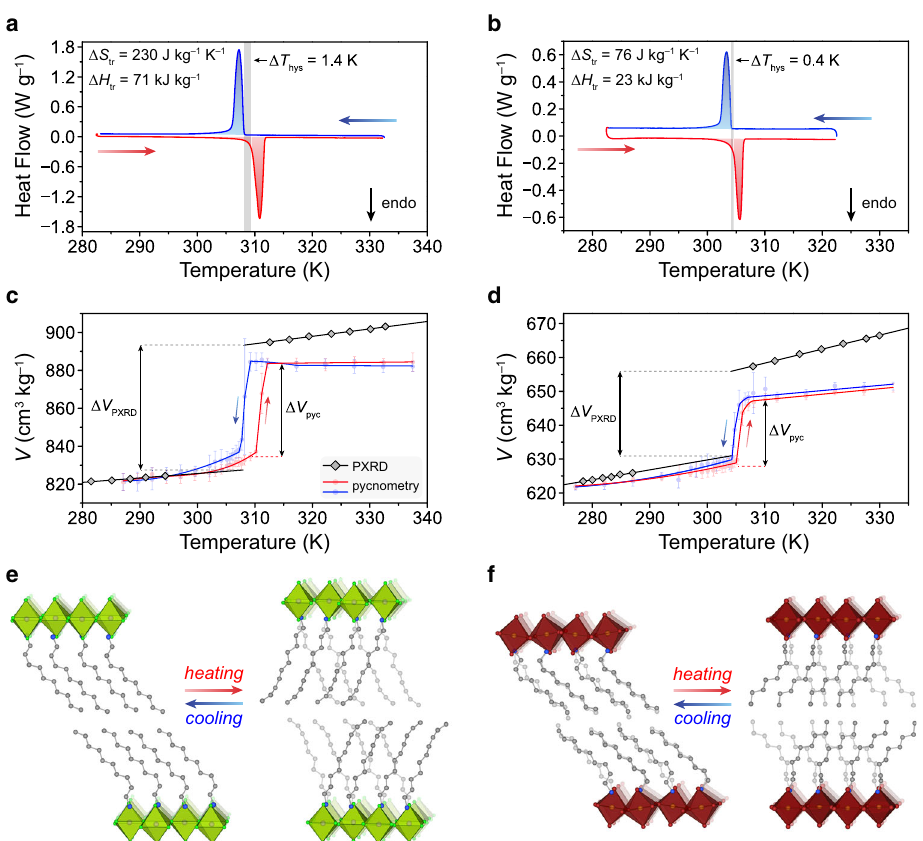
Fig. 2 Thermally induced hydrocarbon order – disorder transitions in (DA) 2 MnCl 4 and (NA) 2 CuBr 4 at ambient pressure. Differential scanning calorimetry (DSC) traces for powder samples of ( a ) (DA) 2 MnCl 4 and ( b ) (NA) 2 CuBr 4 at 1 bar with heating (red) and cooling (blue) rates of 2 K min − 1 . Thermal hysteresis ( Δ T hys ) is indicated by the vertical gray bars. Note that Δ T hys is calculated as the difference between heating and cooling transition onset temperatures, with Δ T hys = T tr,heating – T tr,cooling . Speci fi c volumes obtained from variable-temperature powder X-ray diffraction and He pycnometry measurements are used to determine the volume changes, Δ V , that accompany the order – disorder transition for ( c ) (DA) 2 MnCl 4 and ( d ) (NA) 2 CuBr 4 . Variable-temperature crystal structures of the low-temperature (LT) and high-temperature (HT) phases of ( e ) (DA) 2 MnCl 4 and ( f ) (NA) 2 CuBr 4 . Note that the LT crystal structures were both obtained at 270 K, while the HT crystal structures were obtained at 330 K and 335 K for (DA) 2 MnCl 4 and (NA) 2 CuBr 4 , respectively. Purple, orange, green, brown, gray, and blue spheres represent Mn, Cu, Cl, Br, C, and N atoms, respectively. H atoms are omitted for clarity. Note that DA chains are disordered over a special position in both the LT and HT phases, while NA chains are modeled with two-part disorder in the LT phase and disordered over a special position in the HT phase. Geometric parameters obtained from single-crystal X-ray diffraction experiments are summarized in Supplementary Tables 14 –